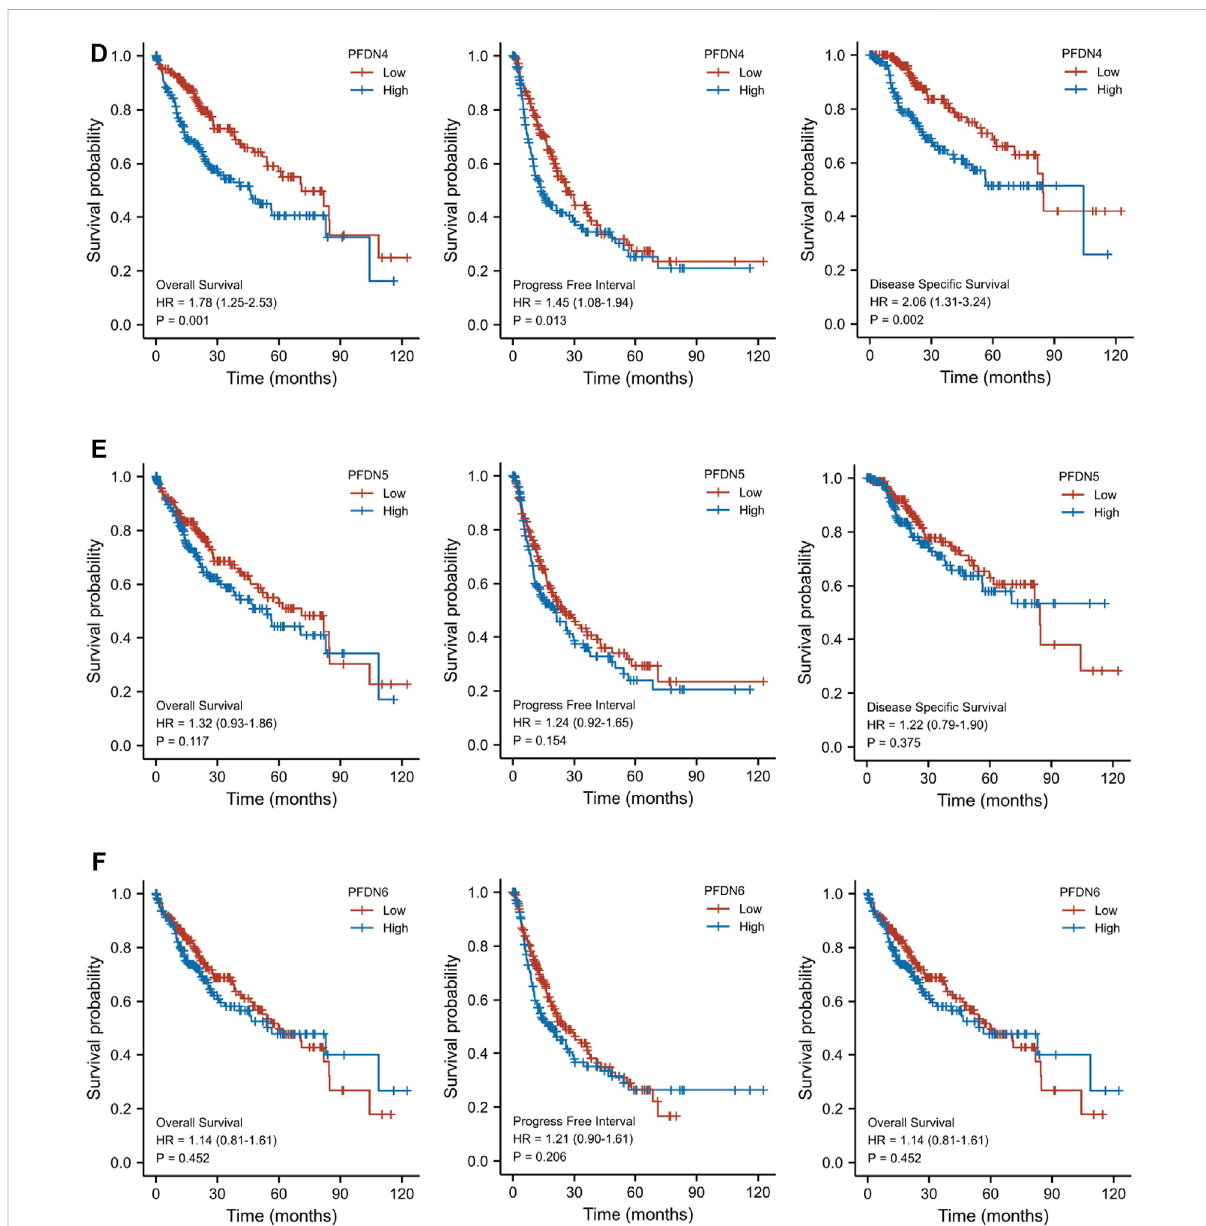
FIGURE 2 Prognostic value of the mRNA level of the PFDN family in HCC (Kaplan – Meier Plotter). (A) Higher expression of PFDN1 was signi fi cantly associated with OS and PFI of patients with HCC. (B) Higher transcriptional expression of PFDN2 was signi fi cantly associated with OS and DSS of patients with HCC. (D,E) Higher expression of VBP1 and PFDN4 was signi fi cantly associated with OS, PFI, and DSS of patients with HCC. (F,G) However, PFDN5 and PFDN6 mRNA expression showed no correlations with prognosis of patients with